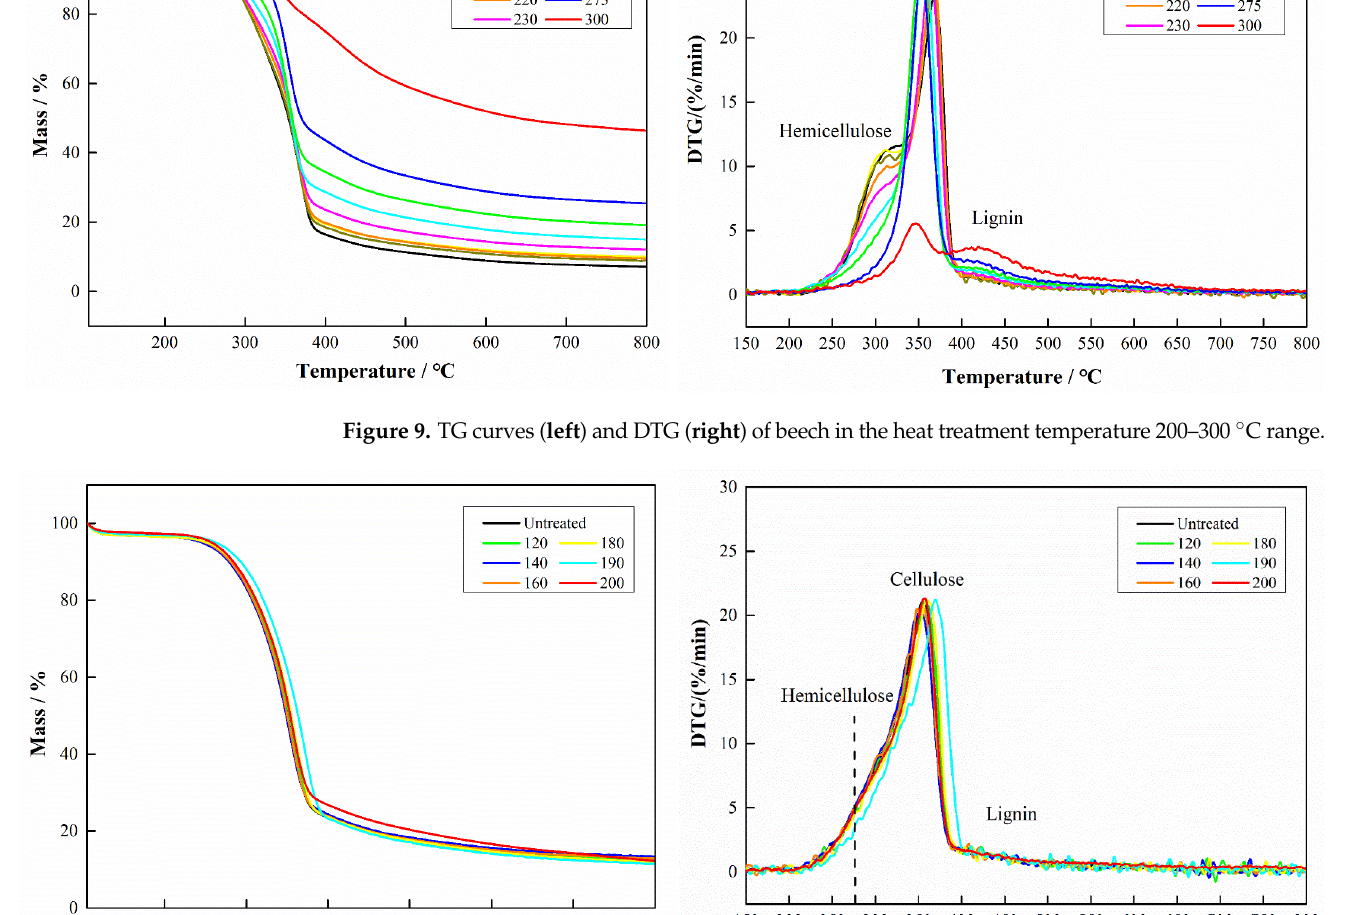
Figure 9. TG curves ( left ) and DTG ( right ) of beech in the heat treatment temperature 200–300 °C range.